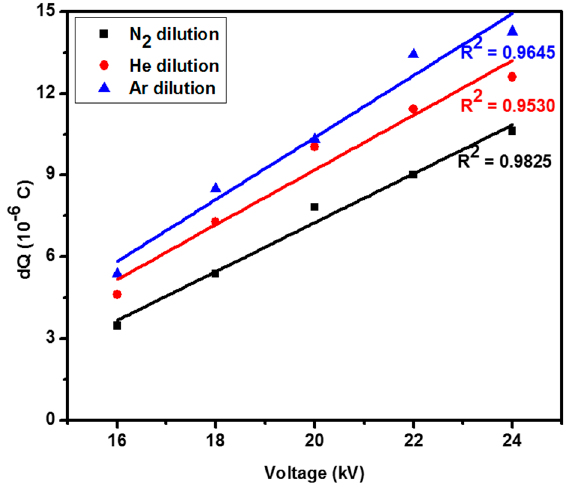
Figure 3. Total charge transfer per half cycle as a function of applied voltage (Flow rate 30 mL/min, CO 2 :diluent gas = 1:2, Glass beads packed, Plasma frequency 50 Hz).